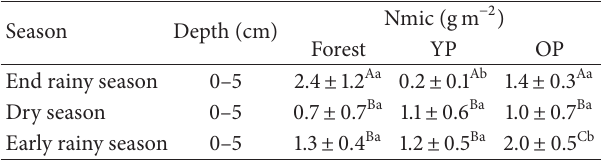
Table 4: Soil microbial nitrogen (Nmic) in the forest and pastures.